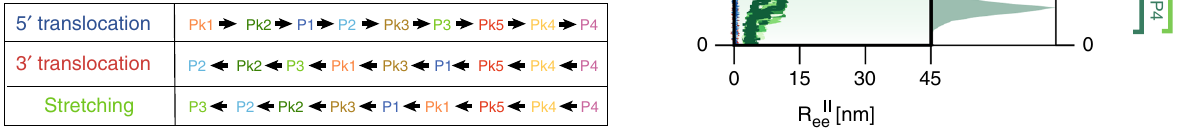
Fig. 2 Zika xrRNA response to pore translocation and stretching. a Typical snapshots of the initial stages of translocation and stretching processes; the arrows indicate the direction of the force applied inside the pore or at the chain ends. b Temporal trace of the translocated chain fraction from the 5 0 (blue) and 3 0 (red) ends for 20 trajectories at the reference temperature T = 300 K and force-ramping rate r = r 0 = 270 pN/ μ s. The green traces show the longitudinal end-to-end distance, R k ee for 20 stretching trajectories at the same values of T and r . The fi lled curves on the right are the associated height- normalized distributions of the critical forces for translocation and mechanical unfolding, obtained with Gaussian kernel-density estimators. c Typical order of rupture of native contacts during translocation and stretching, see also Supplementary Fig. 2. Secondary elements in a , c are highlighted with the same color code of Fig. 1 a